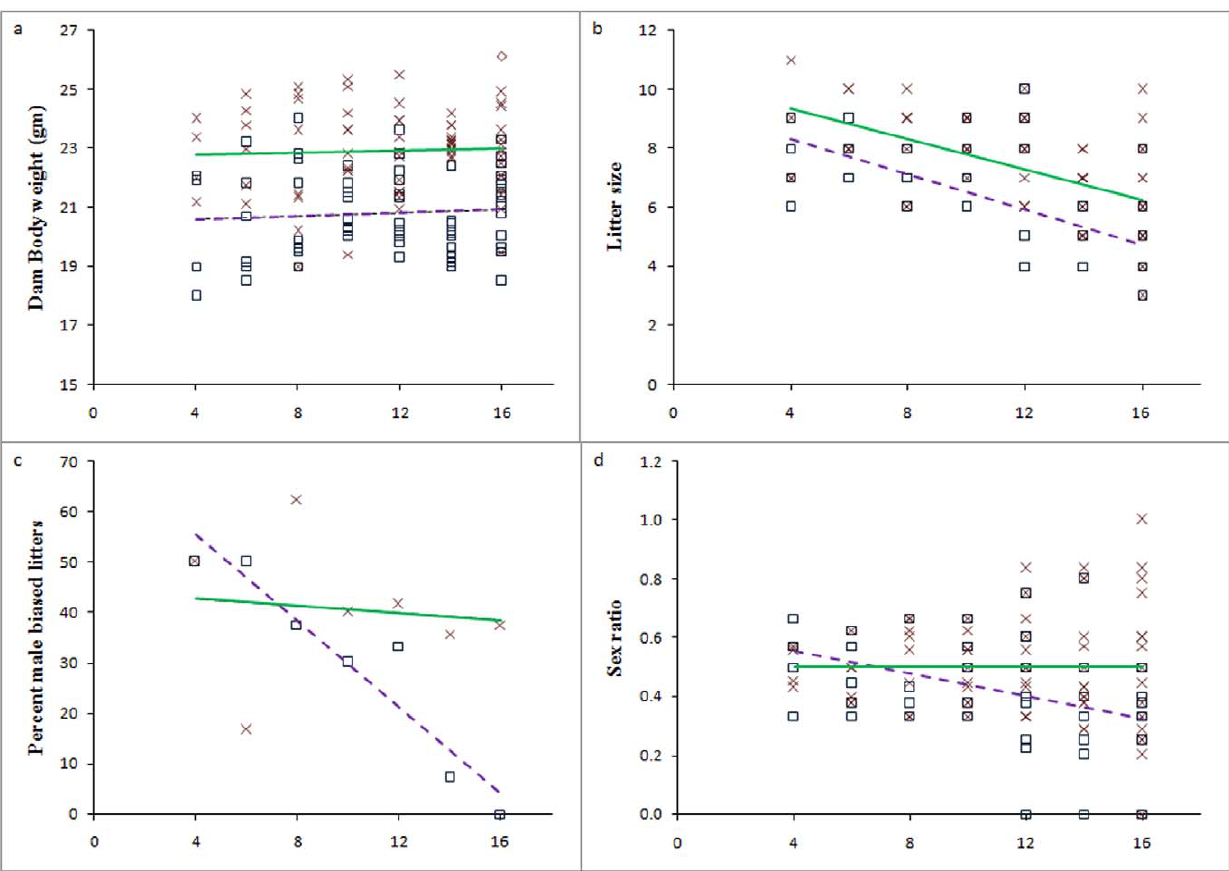
Figure 1. Dam body weight at conception and outcomes of pregnancy in NFD and HFD groups. a) Dam body weight (b=0.03 vs. 0.02, both P , 0.05), b) Litter size (b= 2 0.30 vs. 2 0.26, both P , 0.01), c) Percent male biased litters (b= 2 4.29, P , 0.01vs. 2 0.36, P . 0.05) and d) Sex ratio ( b = 2 0.02, P , 0.01 vs. 0.00, P . 0.05). Squares represent NFD, crosses represent HFD, broken and solid lines are linear trends through NFD and HFD datasets, respectively.